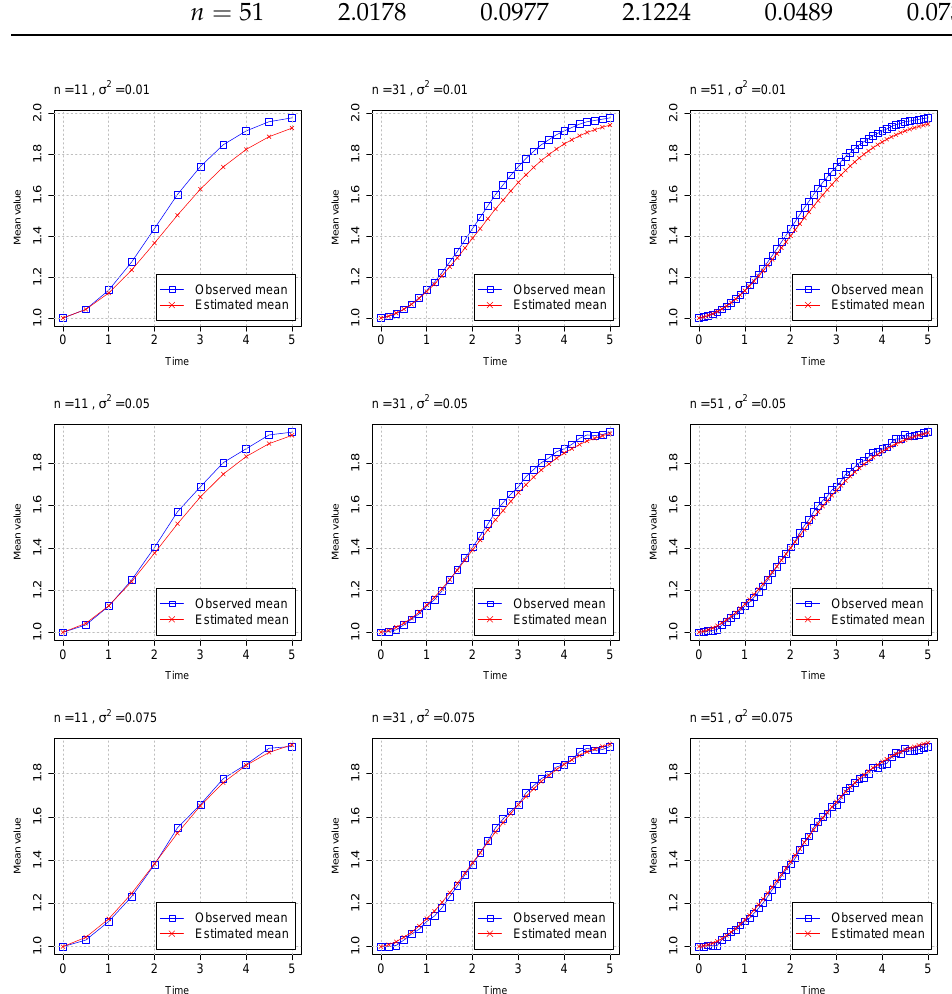
Figure 5. Observed mean vs. estimated mean obtained from simulated sample paths with the estimated parameters, for the case of a hyperbolastic process of type